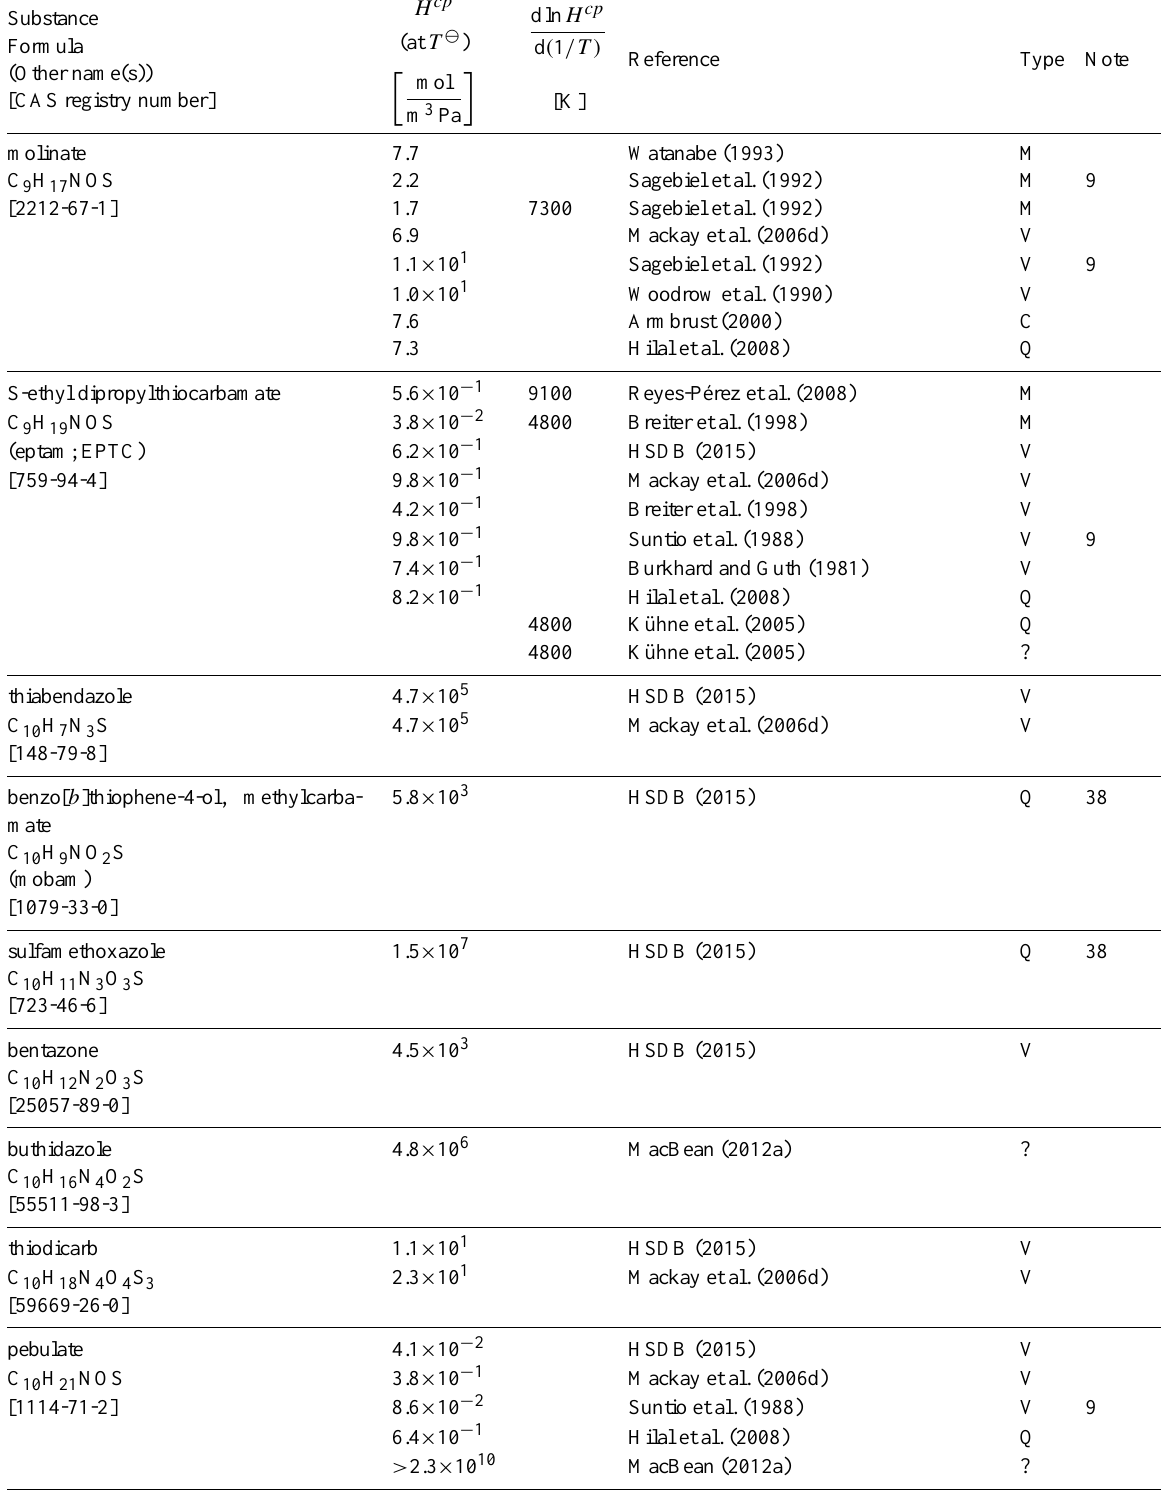
Table 6: Henry’s law constants for water as solvent